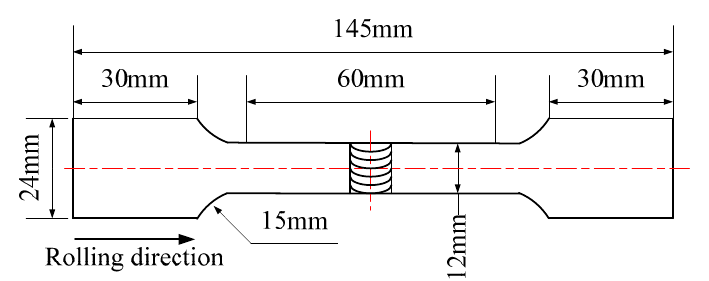
Figure 1. Schematic of tensile specimen.